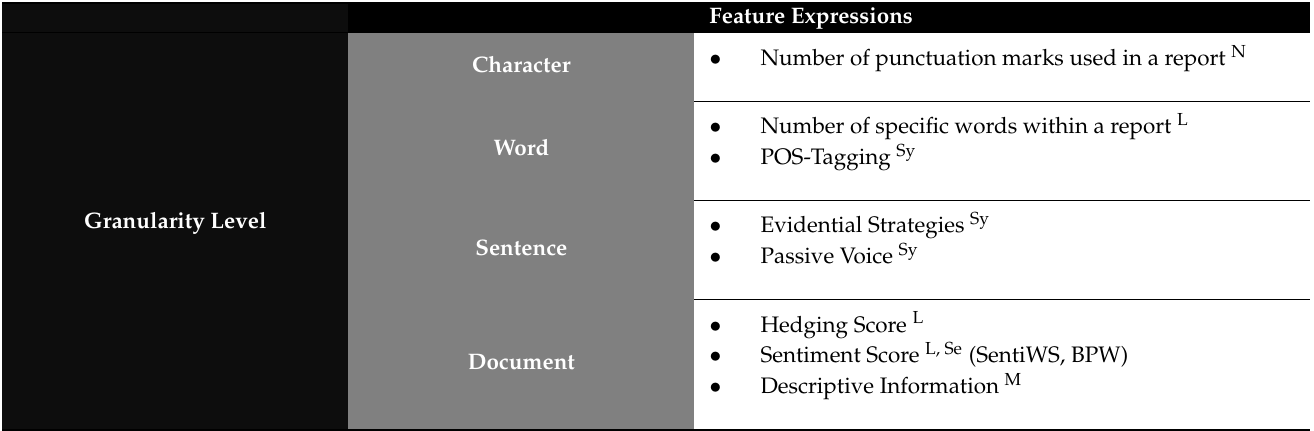
Table 3. Classification of extracted text mining